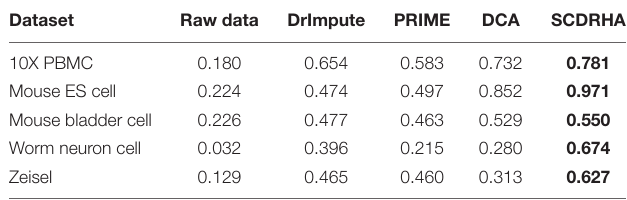
Bold values indicate the highest score in the row and the corresponding method has the best